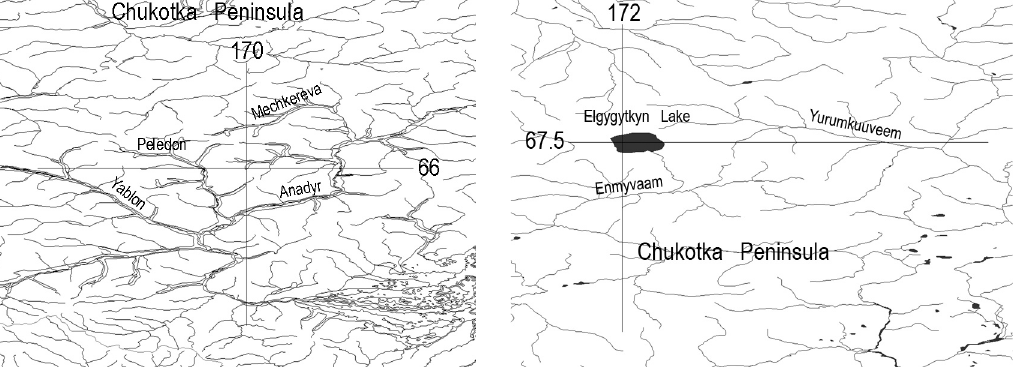
Fig. 24. Map of Right side of Anadyr River Basin (Yablon, Peledon and Mechkereva Rivers) calving grounds.